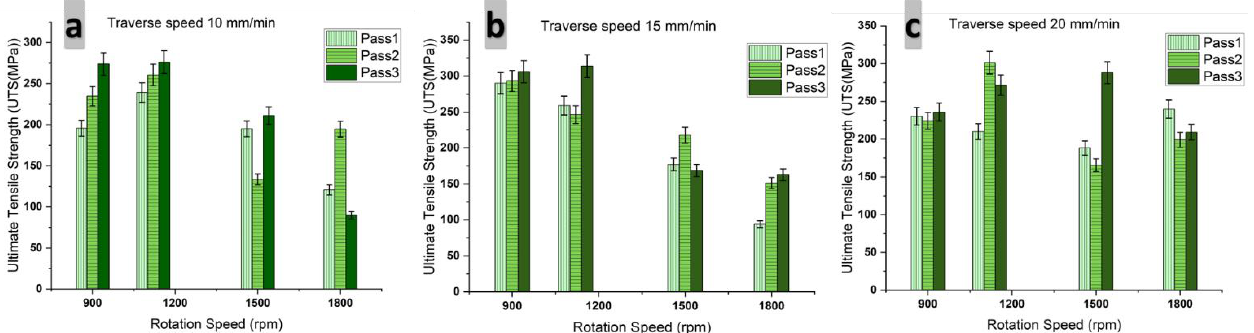
Figure 8. Effect of processing parameters on the ultimate tensile strength. ( a ) processing speed 10 mm/min; ( b ) 15 mm/min; ( c ) 20 mm/min.